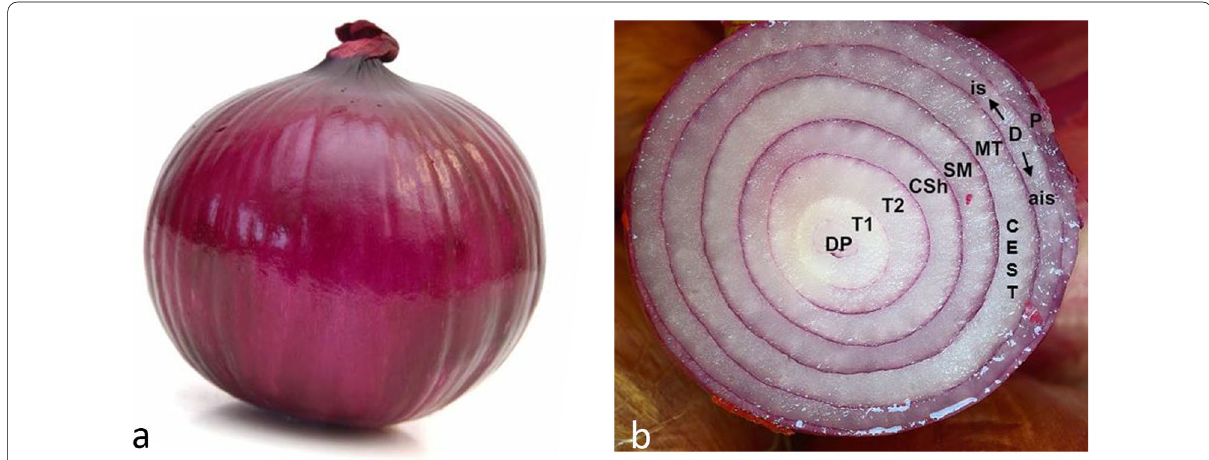
Fig. 1 The magnitude image a is the sum of different intravoxel sources of MRI contrast ( b ), here schematically represented in an onion model. DP Proton density; T1 longitudinal relaxation time; T2 transverse relaxation time; CSh chemical shift; SM magnetic susceptibility; = = = = = MT magnetization transfer; CEST chemical exchange saturation transfer; D diffusion, isotropic (is) and anisotropic (ais); P = = = =